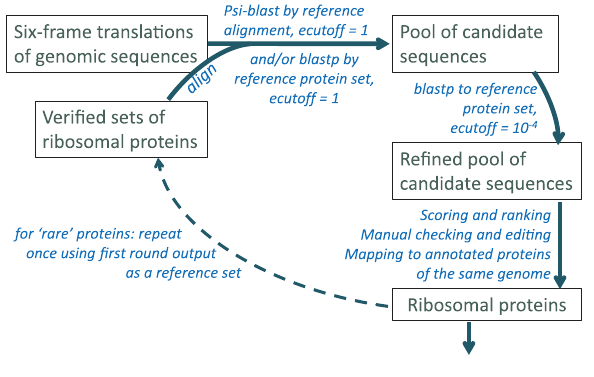
Figure 1. Overall scheme of the procedure.